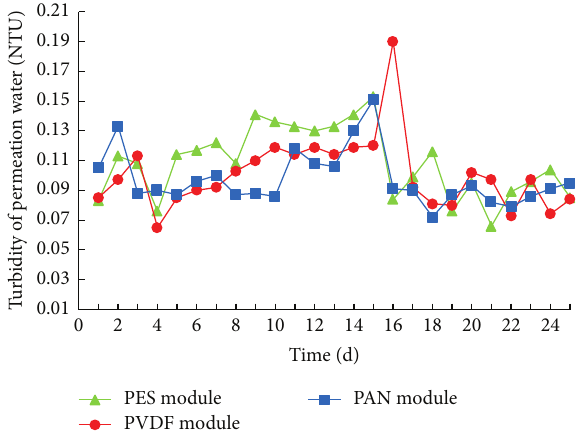
Figure 2: Turbidity trend of UF filtrate during the test period.